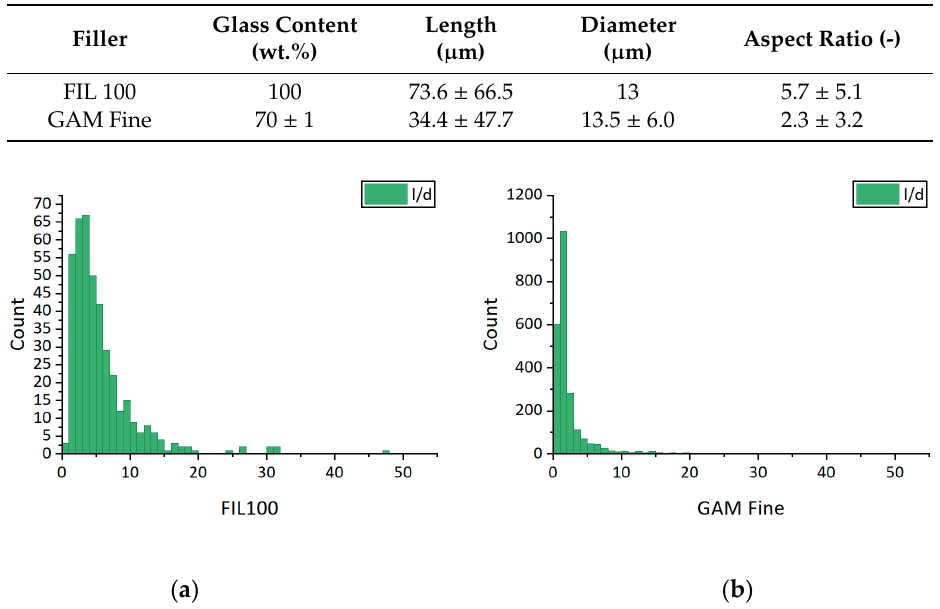
Table 1. Glass fiber content (wt.%), mean fiber length (l), mean fiber diameter (d), and aspect ratio (-) of FIL 100 virgin glass fibers and GAM fine glass fiber recyclate (estimated by thermogravimetric analysis).